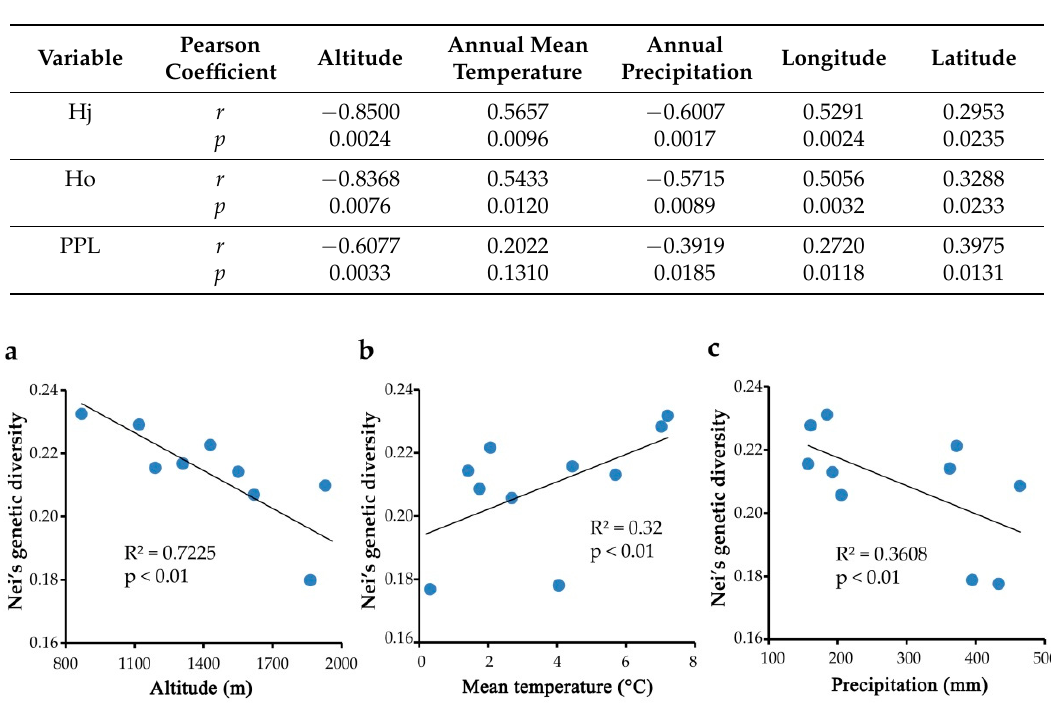
Figure 4. Regression analysis for Hj and environmental factors (( a ) Hj and altitude; ( b ) Hj and mean temperature; ( c ) Hj and precipitation).